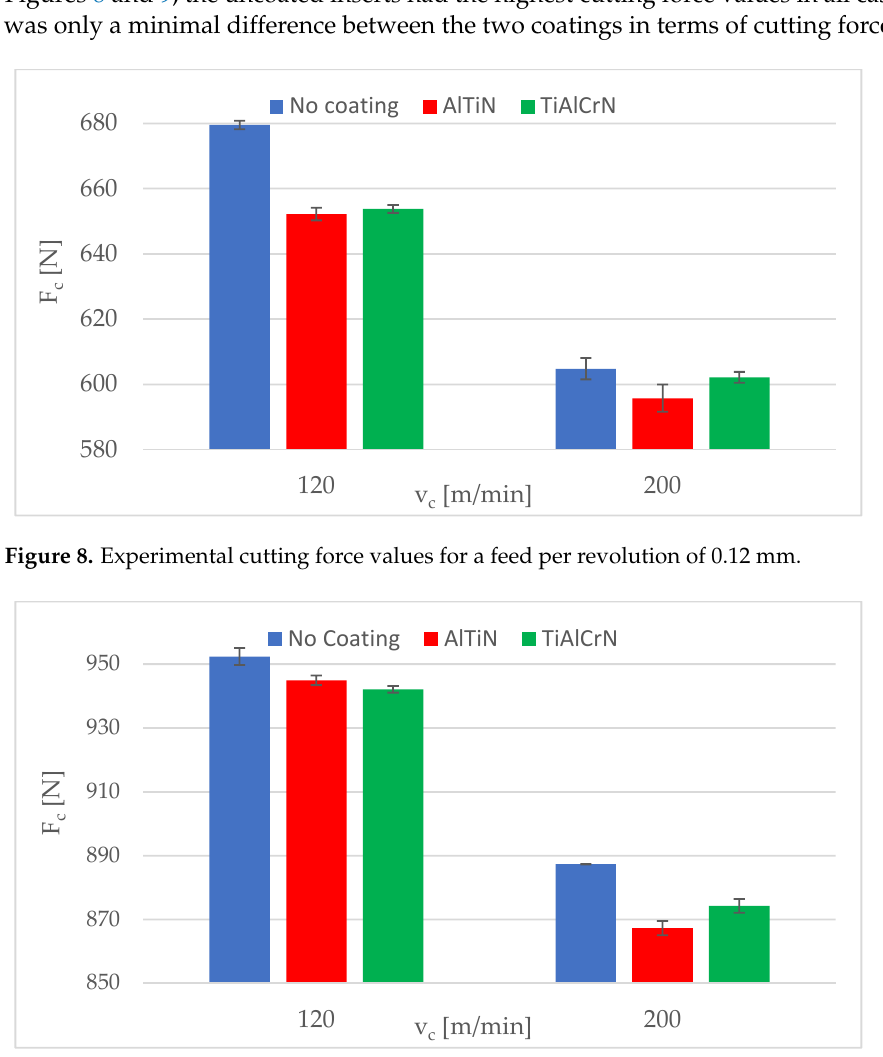
Figure 9. Experimental cutting force values for a feed per revolution of 0.20 mm.